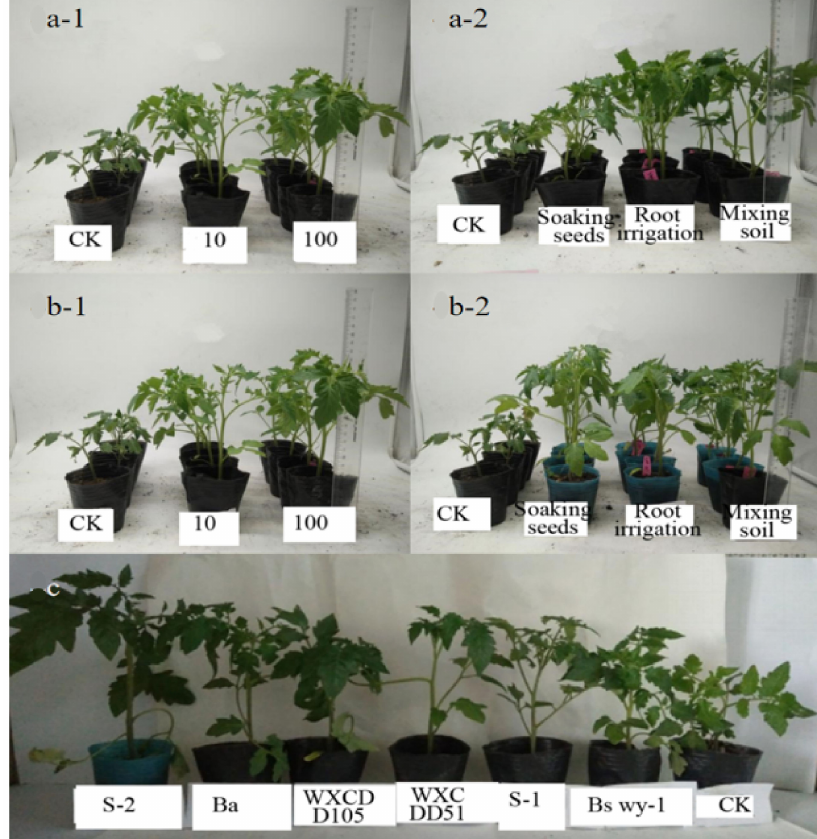
Figure 4. ( a ) Effects of combination S-1 fermentation broth on the growth of tomato seedlings with different concentrations (1) and different treatments (2). ( b ) Effects of combination S-2 fermentation broth on the growth of tomato seedlings with different concentrations (1) and different treatments (2). ( c ) Comparison of effects of single and mixed fermentation broths on the growth of tomato